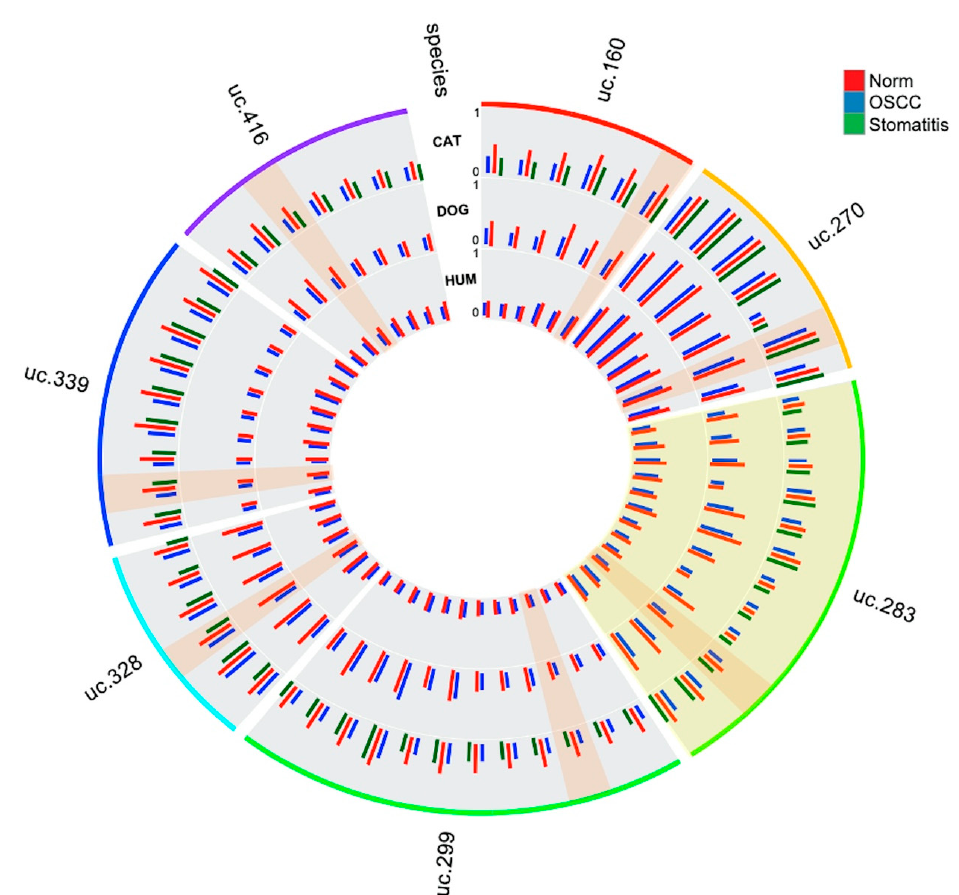
Figure 6. Circular visualization of methylation levels for each of the seven UCNEs in the different tissues for cat, dog, and human samples. UCNE 283 is highlighted as it showed the best discriminative power between SCCs and normal tissues for cats, dogs, and humans. For each UCNE, the best CpG to discriminate SCCs from control samples is also highlighted.